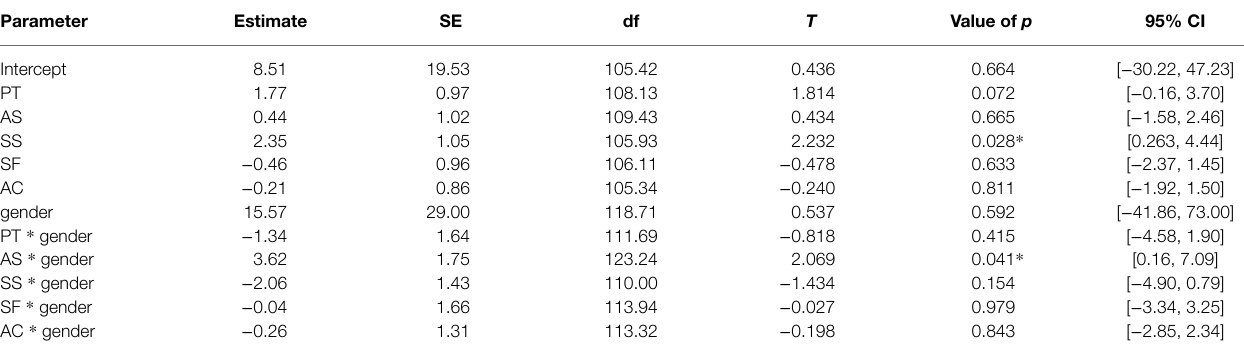
TABLE 7 | Fixed effects of the linear multilevel model testing the interaction effect of coping styles and gender on situational coping. Parameter